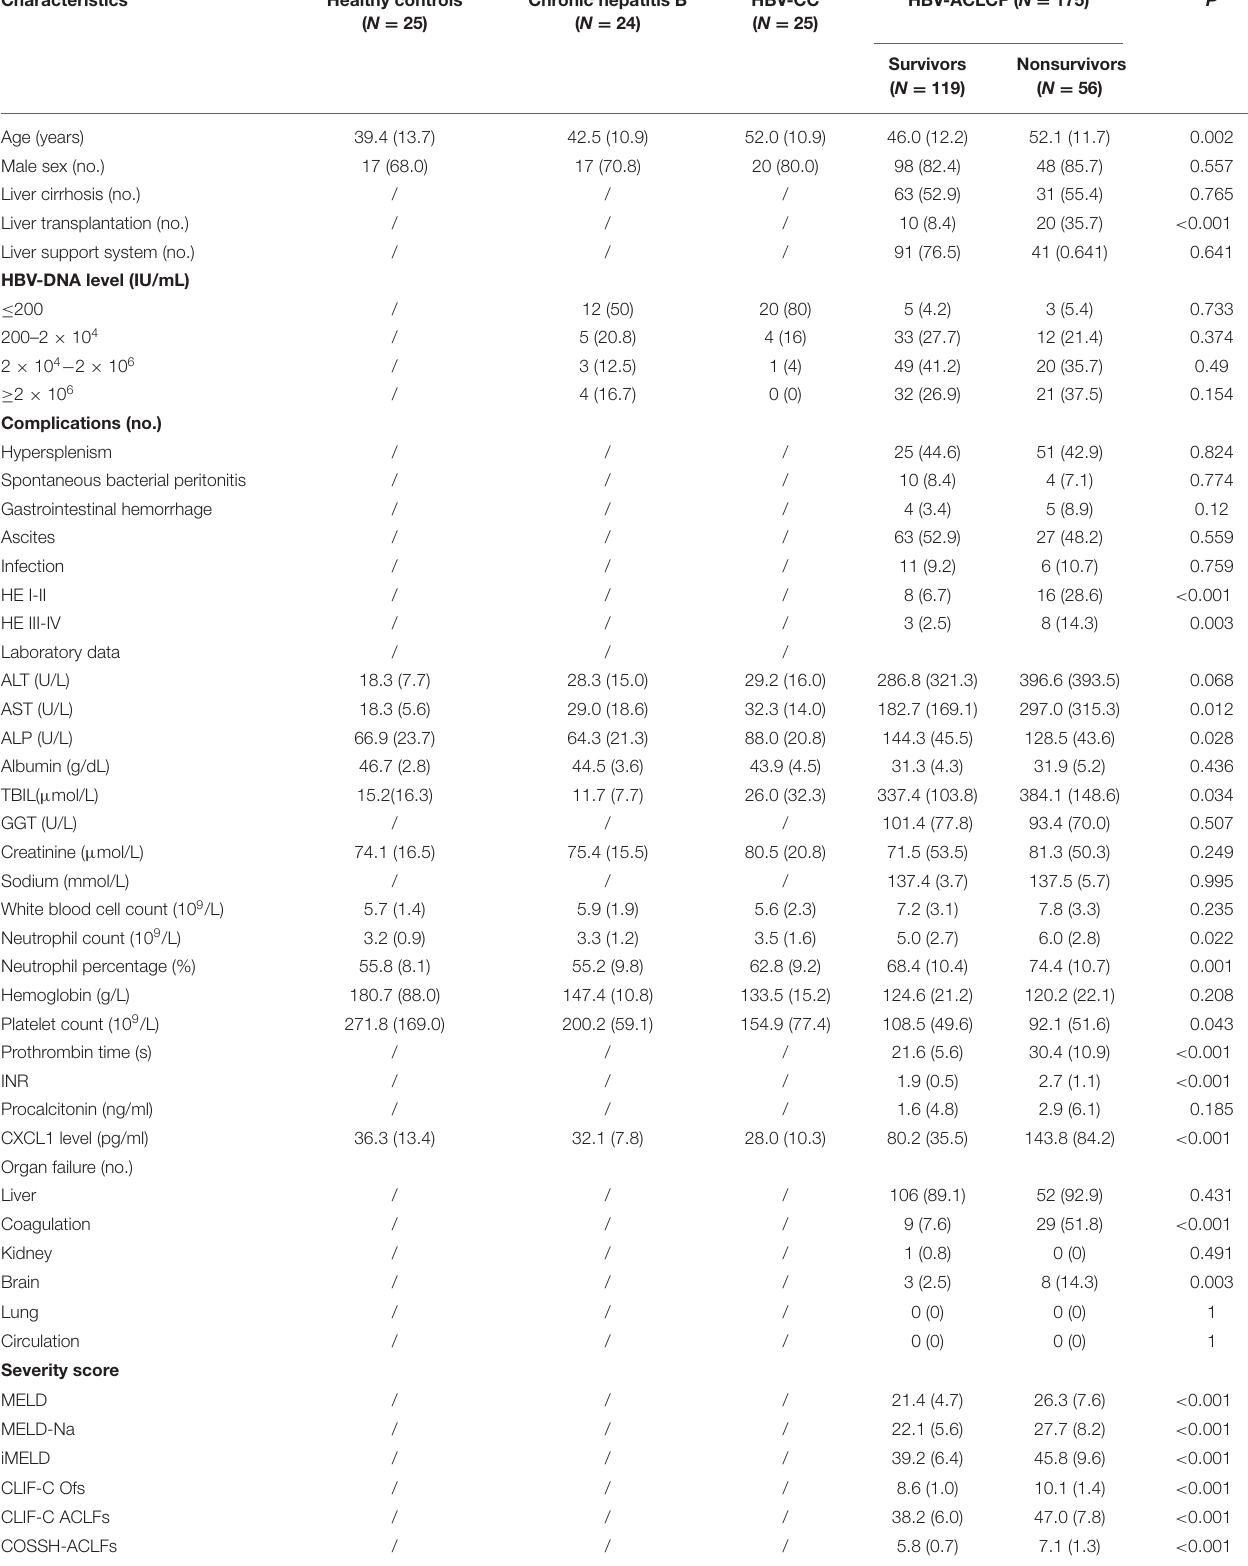
TABLE 1 | Comparison of demographic and clinical characteristics of subjects.